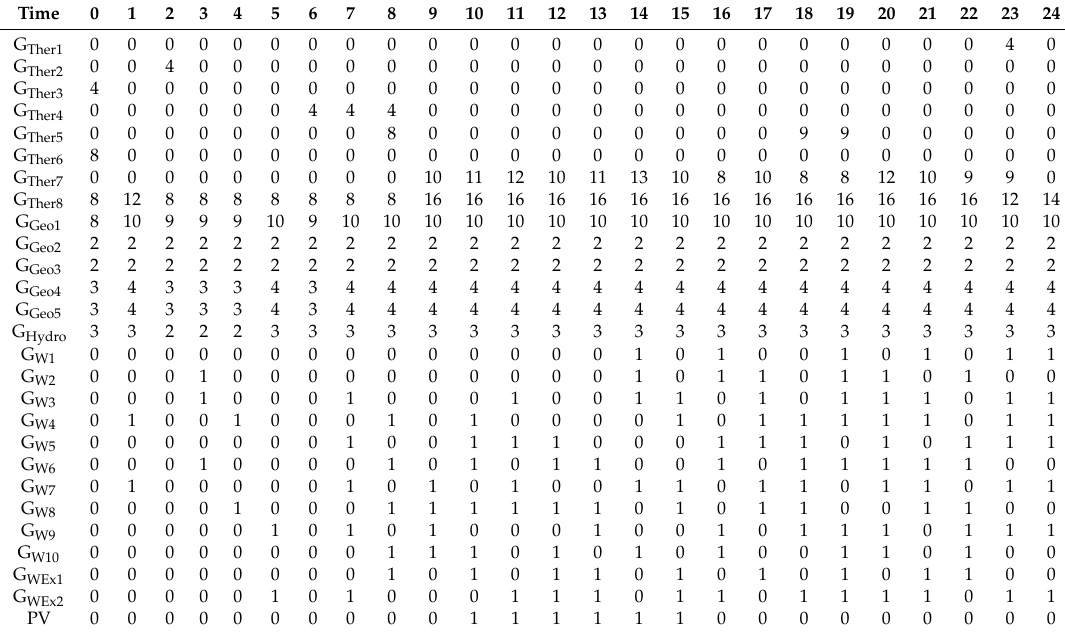
Table 4. Scheduling of generation units with renewable integration and theoretical expansion (MW).